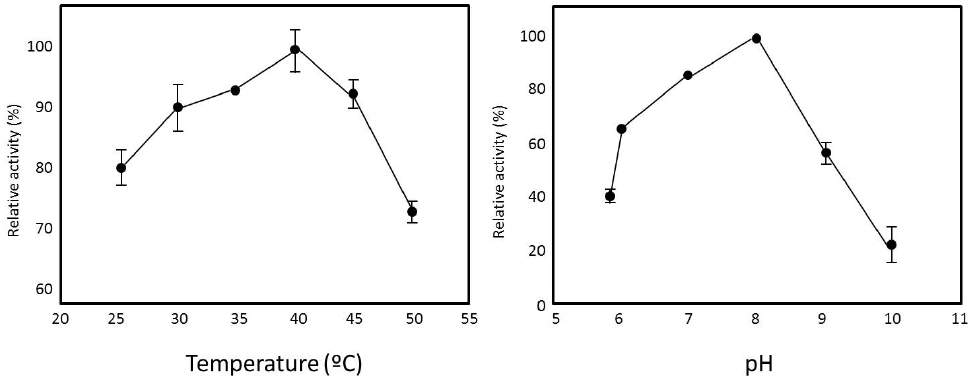
Figure 3. Effect of temperature and pH on the hydrolysis of PET by the cutinase of Fusarium oxysporum . Image extracted from